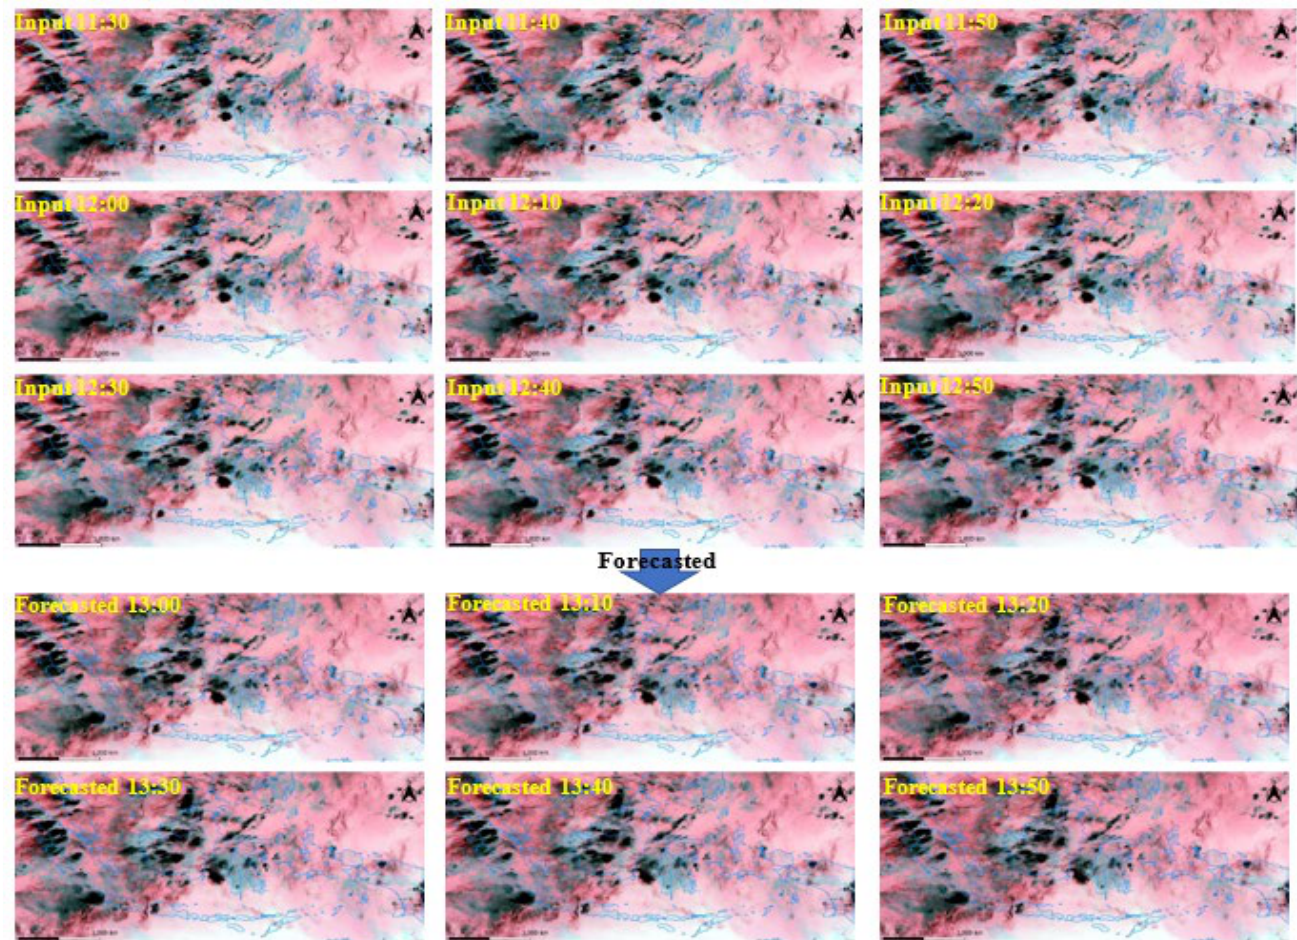
Figure 4. Himawari-8 LSTM forecast results.